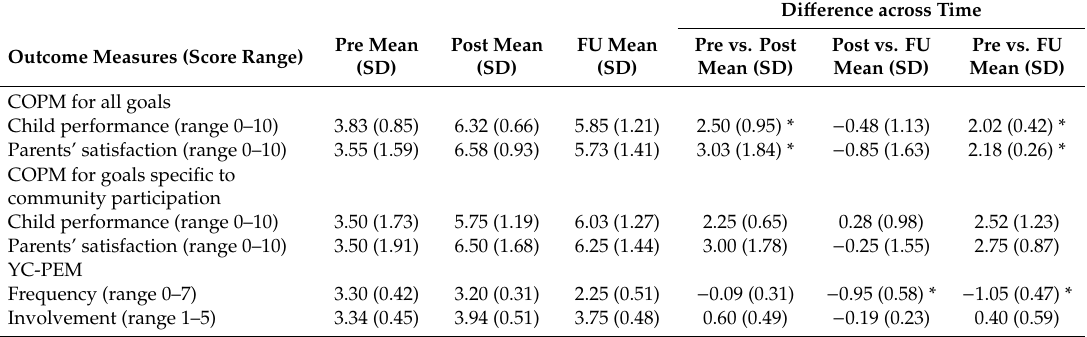
Table 3. Aggregated scores of outcome measures related to goals and community participation over